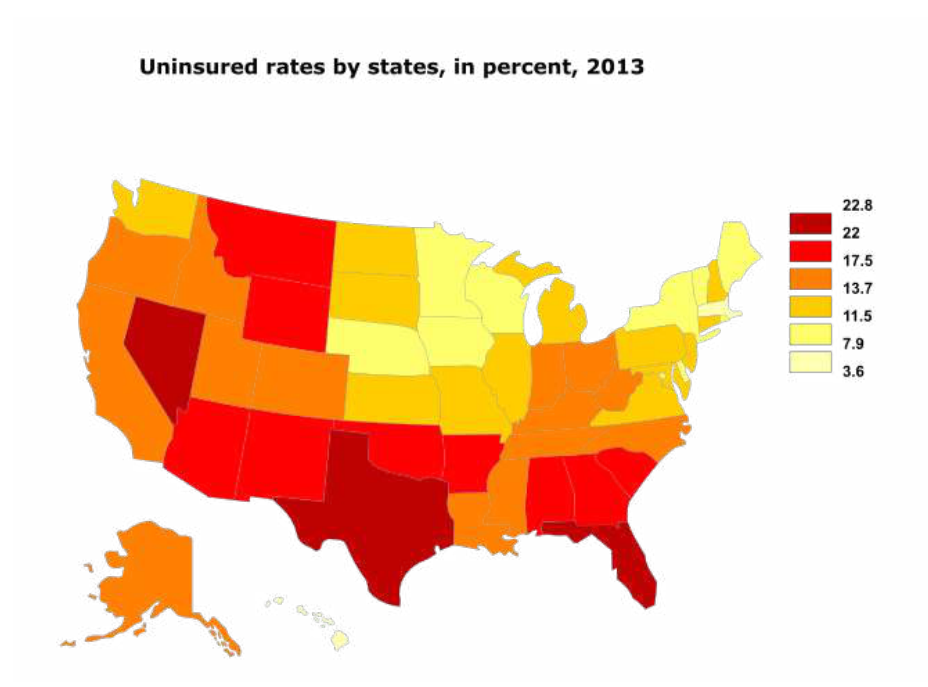
Adapted from the Kaiser Family Foundation.